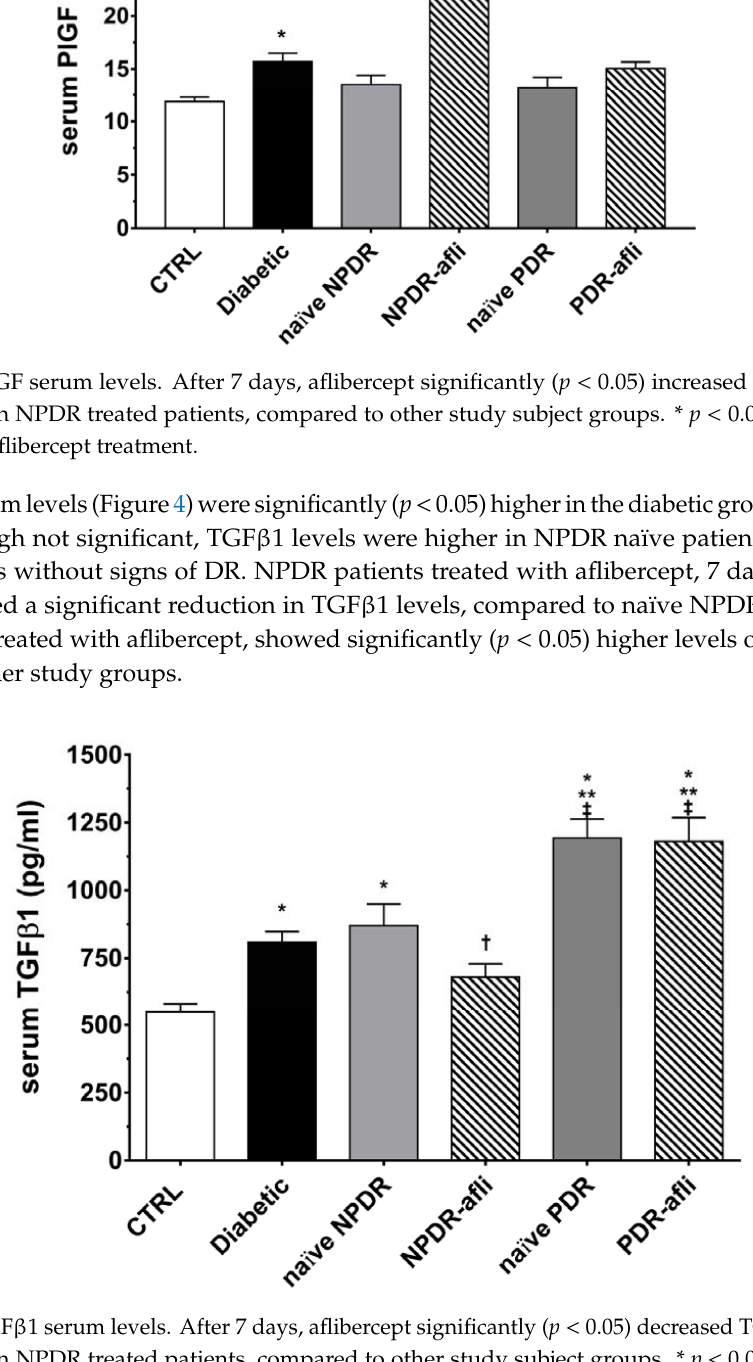
Figure 4. TGF β 1 serum levels. After 7 days, aflibercept significantly ( p < 0.05) decreased TGF β 1 serum levels only in NPDR treated patients, compared to other study subject groups. * p < 0.05 vs. CTRL; ** p < 0.05 vs. diabetic patients without signs of DR; † p < 0.05 vs. NPDR naïve patients; ‡ p < 0.05 vs. NPDR either naïve or treated patients. NPDR either naïve or treated